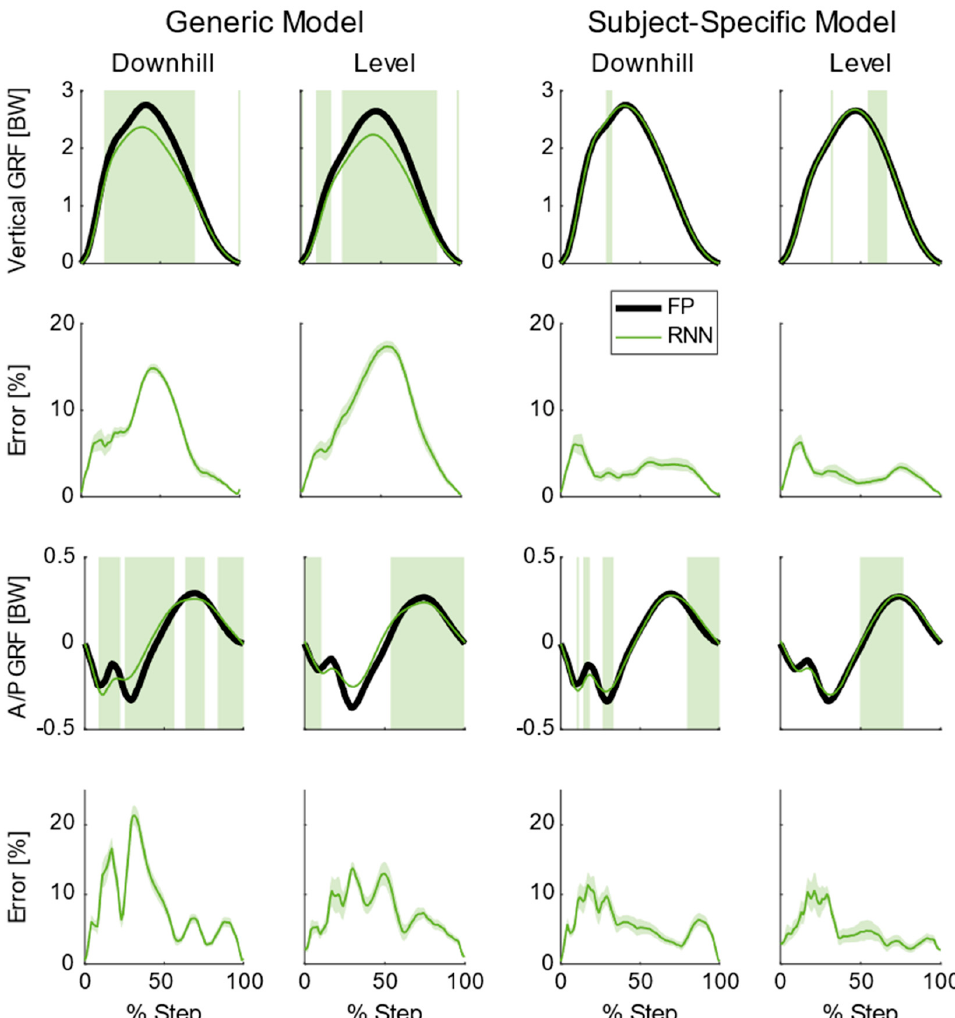
Figure 7. Subject − averaged (N = 18) ground reaction forces (GRFs), model predictions, and model errors for running downhill and level ground at 3.4 m/s for a single subject. The left two columns represent a generic model that was trained on the other 17 subjects in the study. The right two columns represent a subject − specific model that is trained on 17 subjects plus ≈ 10% of the data from the subject illustrated. The top row shows the average vertical GRF from the force platform (FP) along with average recurrent neural network (RNN) predictions. Areas shaded green are where there were significant differences between the FP and RNN ( p < 0.05). The second row shows the mean absolute percent error plus/minus one standard deviation for the RNNs in the vertical direction. The third row shows average anterior/posterior (A/P) GRF from the FP and average RNN predictions. Areas shaded green are where there were significant differences between the FP and RNN ( p < 0.05). The bottom row shows the mean absolute percent error plus/minus one standard deviation for the RNNs in the A/P direction.